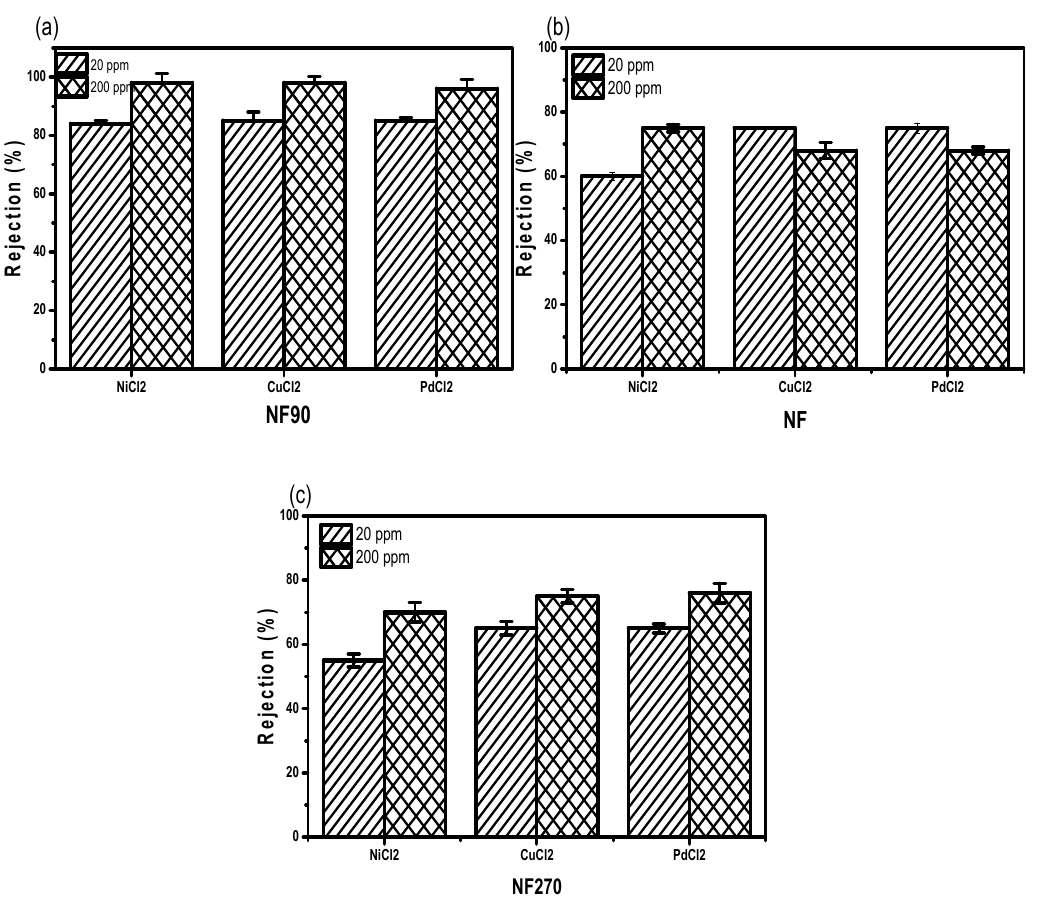
Figure 6. Divalent cation rejection capacities for ( a ) NF90, ( b ) NF, and ( c ) NF270 at two different concentrations. This rejection capacity has to do with membrane surface conditions as well as the concentration level of the salts and molecular weight cut-off for the membrane. However, NF270 has the lowest rejection capacity at 200 ppm because of the high molecular weight cut-off of 200. The low percent rejection observed for NF and NF270 as compared to NF90 was complemented by high surface charge (Figure 6b,c). Due to their sparingly stable conditions, Ni 2+ and Cu 2+ were slightly higher than Pd 2+ , which was not expected. By im- plication, the rejection capacity of the metal cation is not only dependent on concentration, molecular weight, and pH, but also on stability of the ion (Figure 6). In Figure 7, the retention of CuCl and AgCl as a single solution mixture at 200 ppm gave a recovery of R ≈ 93 for Cu + at 5 bar, thus favouring NF90 (dense polyamide material) amongst selected membrane elements at pH 3, compared to pH 2 as a monovalent